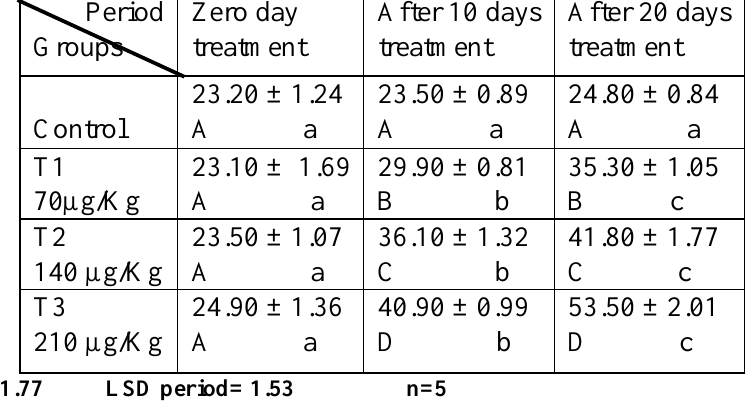
LSD group= 1.77 LSD period= 1.53 n=5 Values represent mean ±S.E Different capital letters mean significant results at (P<0.05) results between different groups Different small letters mean significant results at (P< 0.05) between